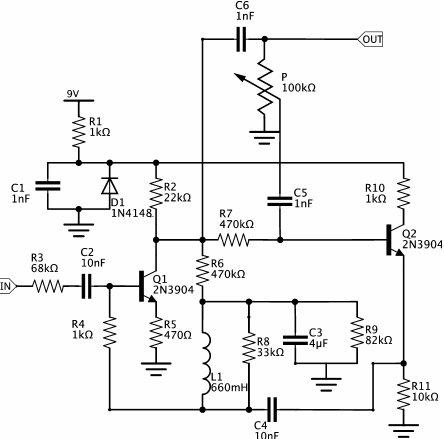
Figure 8. Simulations of the Cry-Baby’s circuit of Figure 9, for the potentiometer parameter α = 0 ( a ) and α = 1 ( b ) in the frequency domain, compared with LT-Spice simulations on the audio range 20 Hz–20 kHz.